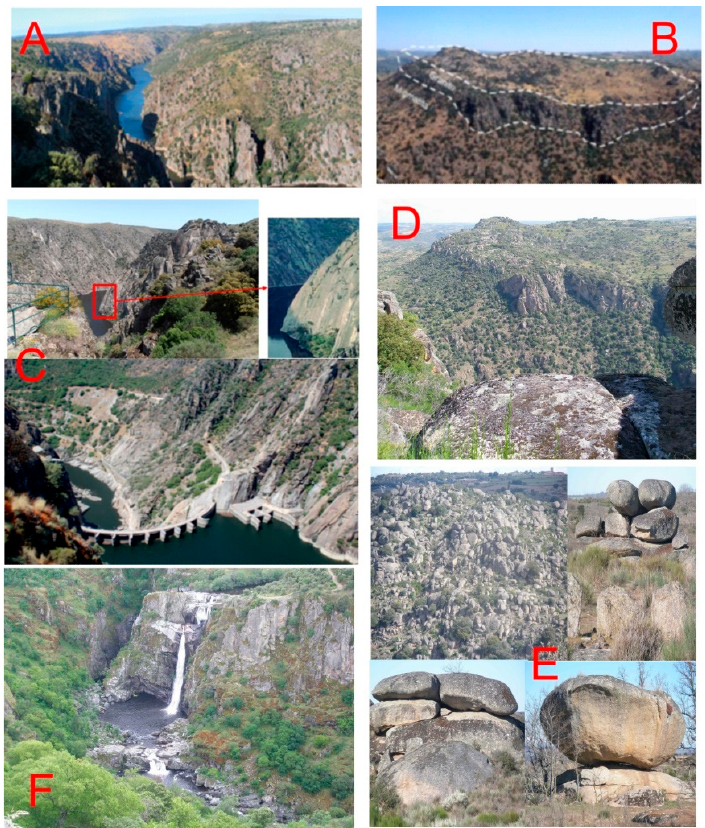
Figure 10. ( A ) Incision of the Duero River in the granite basement and formation of watercress-limes. ( B ) Granite sill highlights on migmatites. ( C ) Image of the flaking of the granite of the Mirador de El Fraile on the left and on the right the dam of the Aldeádavila Dam on the Duero River. ( D ) View of Cerro de San Cristóbal on the left and a rounded granite fragment, which is fractured in two parts on the right. ( E ) Landscapes and granite forms scattered around the Trabanca berrocal. ( F ) Pozo de los Humos waterfall.